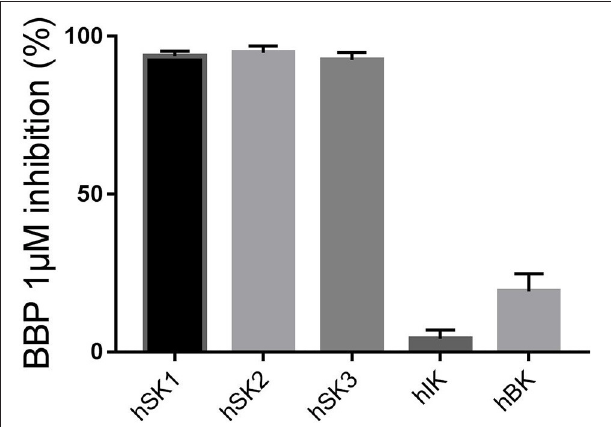
FIGURE 5 | Column graph comparing the inhibitory effect of BBP 1 µ M measured on the manual patch clamp on all calcium-activated potassium channels: SK1 ( n = 6), SK2 ( n = 5), SK3 ( n = 5), IK ( n = 6) and BK ( n = 8) channels. BBP 1 µ M totally inhibited all SK currents as well as 19 ± 6% of BK current. However, the IK channel was not affected by BBP 1 µ M.